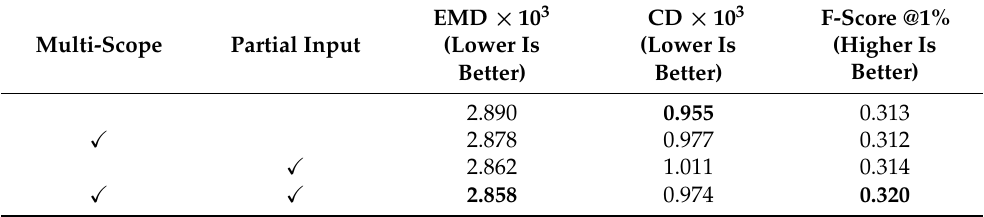
Table 8. Ablation study on partial input in decoder and multi-scope in the encoder using PCN